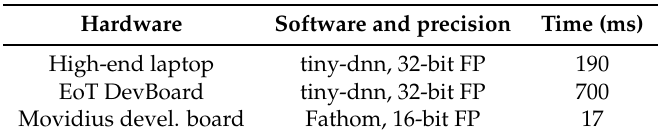
Table 2. Times taken by the inference part of the demonstrator. The EoT DevBoard is the second iteration board (i.e., Figure 1, board in the middle). The Fathom case used only four of the 12 SHAVEs available.